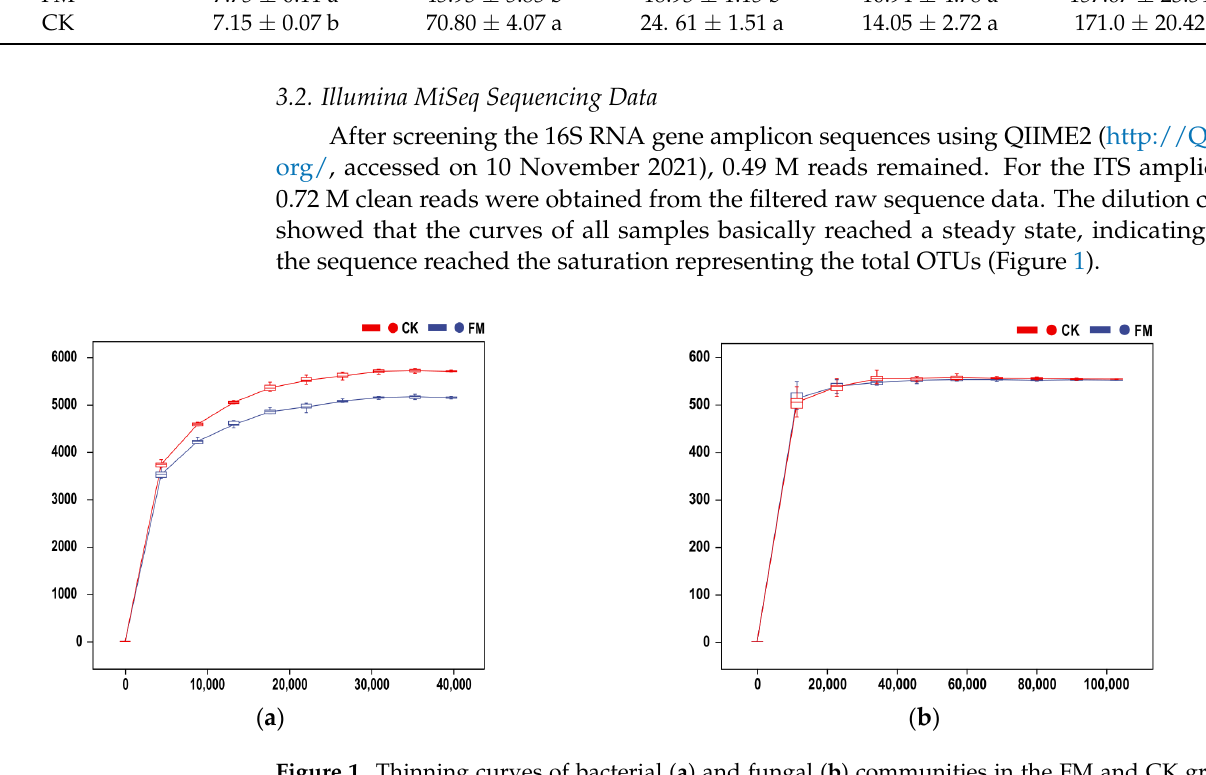
Figure 1. Thinning curves of bacterial ( a ) and fungal ( b ) communities in the FM and CK groups. OTU, operating classification unit.